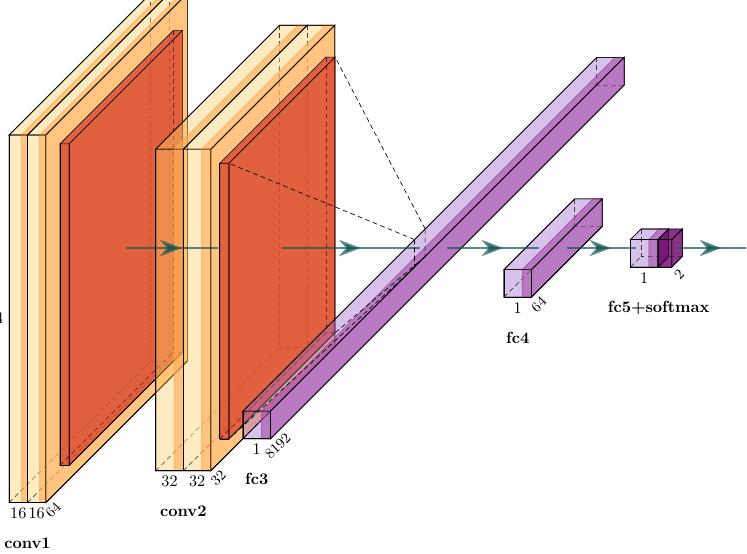
Figure 4. CNN architecture inspired from the VGG16 net used for our